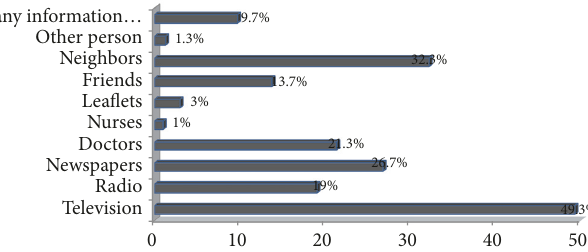
Figure 2: Sources of information regarding falls